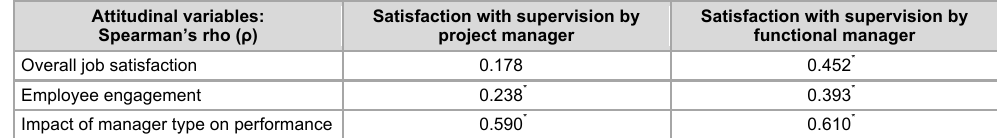
Correlations between satisfaction with manager and overall job satisfaction, employee engagement and manager’s impact on performance Attitudinal variables: Satisfaction with supervision by Satisfaction with supervision by Spearman’s rho (ρ) project manager functional